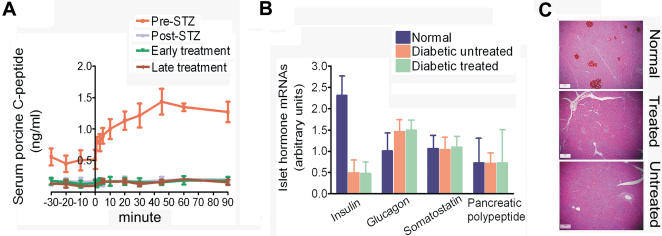
Absence of insulin expression in pancreatic β cells of STZ-diabetic pigs.(A) Persistent abolition of IVGTT-induced rise in serum PCP in the late treatment phase (13–47 wk after hepatocyte transplantation). Data are from 14 pigs. (B) Transcript analyses of islet hormones from pancreata of healthy, untreated diabetic (38–46 wk post-STZ) and treated diabetic (38–49 wk post-STZ) pigs (n = 2 per group) by real time RT-PCR as in Fig. 1E. Insulin mRNA was significantly decreased and glucagon mRNA significantly increased in both groups of diabetic pigs compared to healthy controls (p<0.0001 for all comparisons). Both diabetic groups had similar expression of insulin and glucagon (p = 0.4041 and 0.2308, respectively). Somatostatin and pancreatic polypeptide expression was not significantly different among all groups. (C) Insulin-positive cells in normal islets of a healthy pig cf. absent in diabetic pigs 38 wk post STZ.